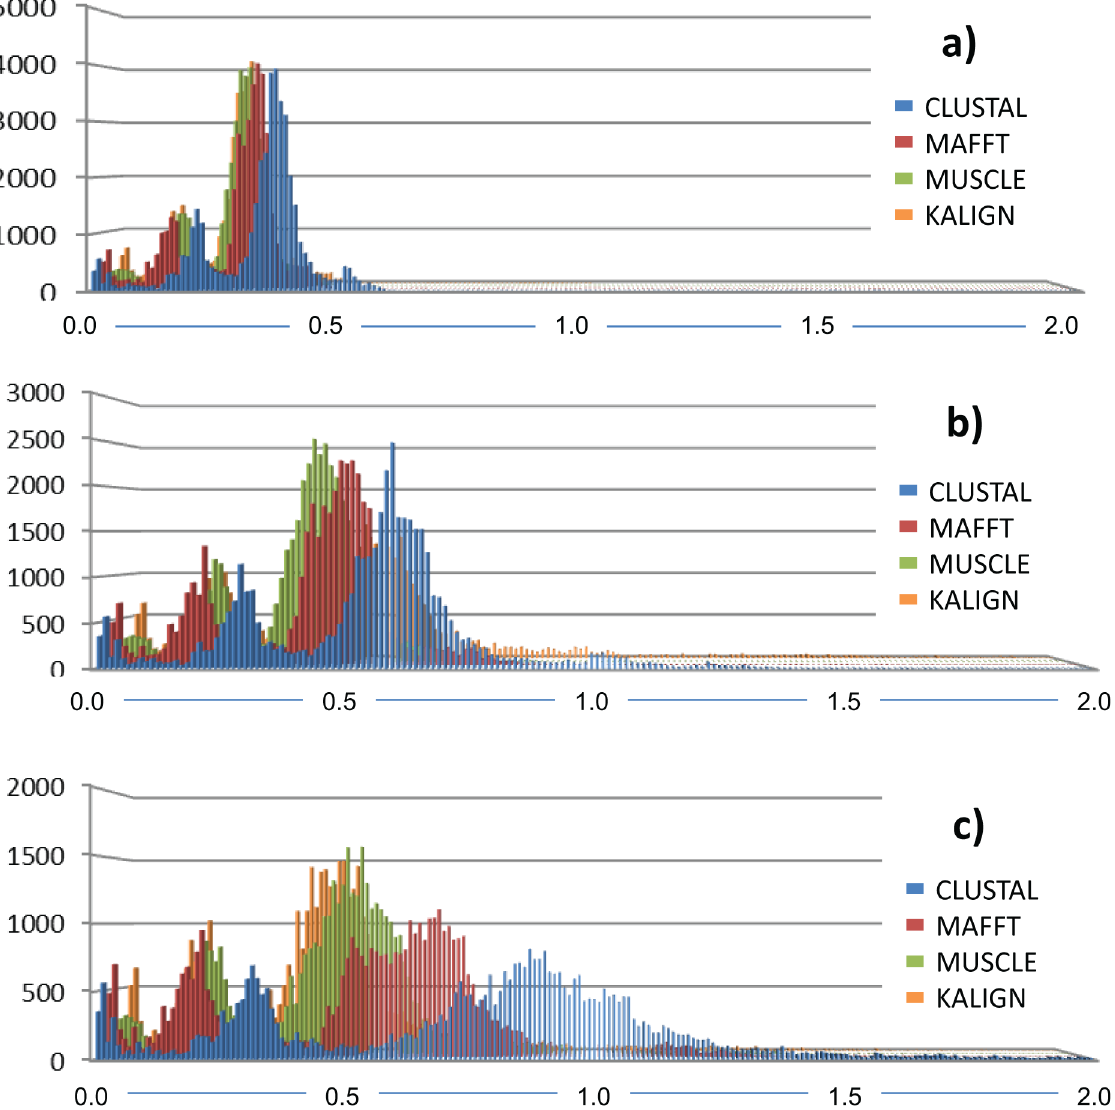
Fig 8. Frequency distribution of pairwise comparisons given the alignment. a) p-distance; b) K2P correction and c) GTR+I+G model to assess the influence of the alignment algorithm on the inferred genetic distance. Alignments were performed using default settings in MUSCLE, MAFFT, CLUSTAL and